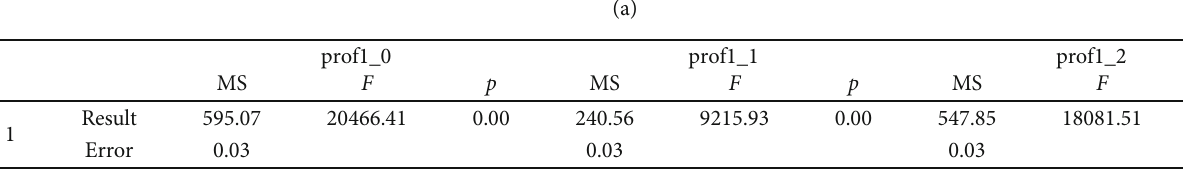
Table 7: The results of the ANOVA test for the fi rst person tested are